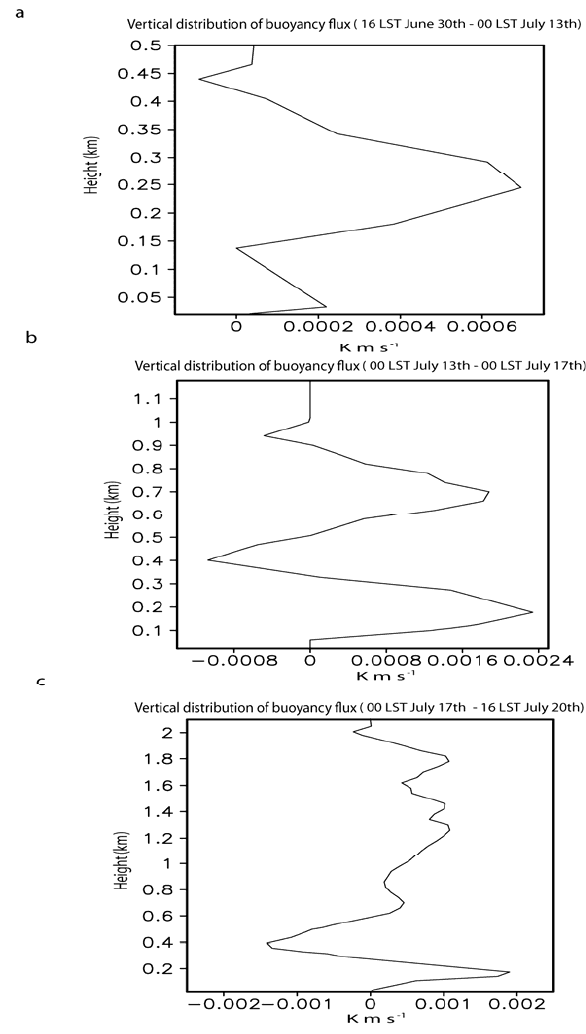
Fig. 11. Vertical distribution of the time- and